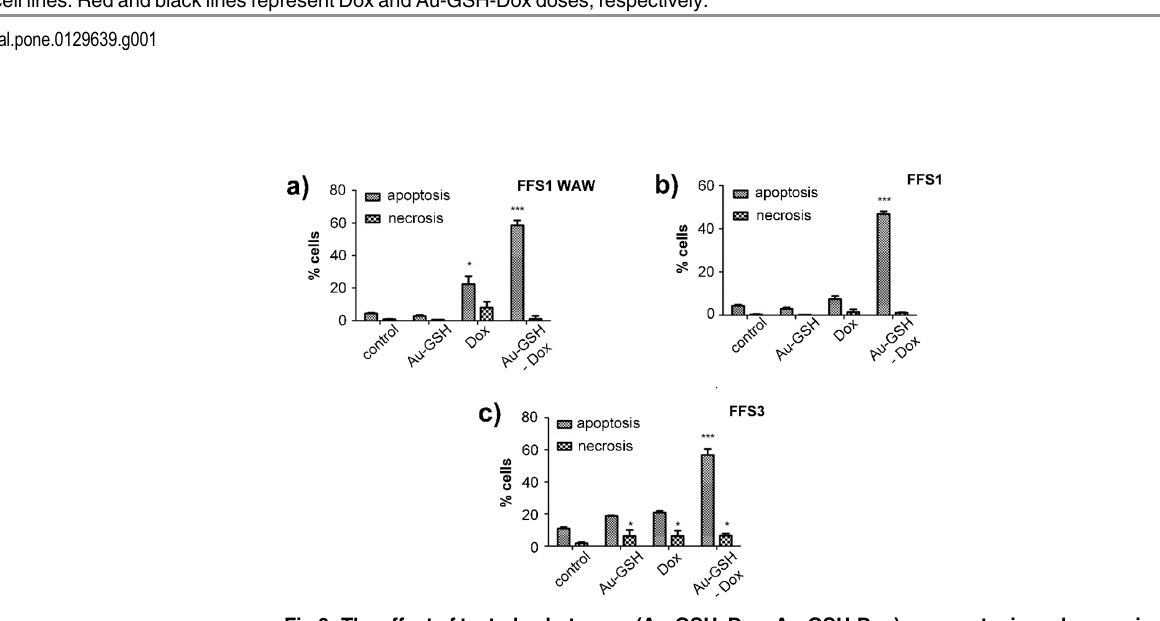
Fig 6. The effect of tested substances (Au-GSH, Dox, Au-GSH-Dox) on apoptosis and necrosis of each cell line: (a) FFS1WAW, (b) FFS1, (c) FFS3. Tested substances were given at concentrations based on the MTT assay results. Statistical analysis was performed using Prism version 5.00 software (GraphPad Software, USA). Unpaired t-test was used, p < 0,05 was described as * , p < 0.01 was marked as ** , p < 0.001 was marked as ***